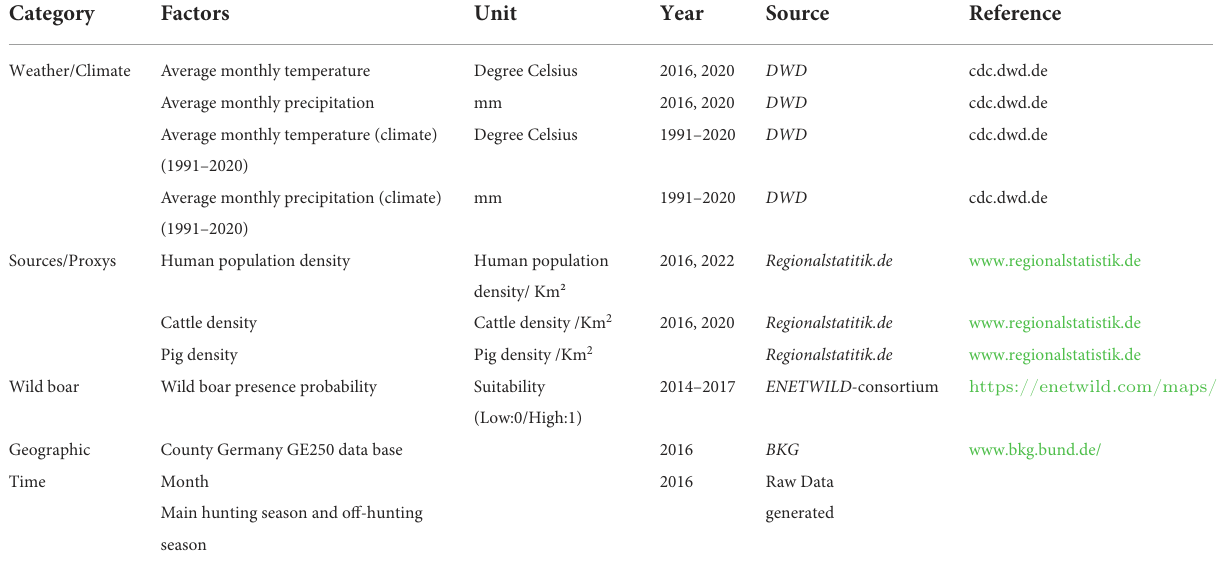
TABLE 1 Collected data and their